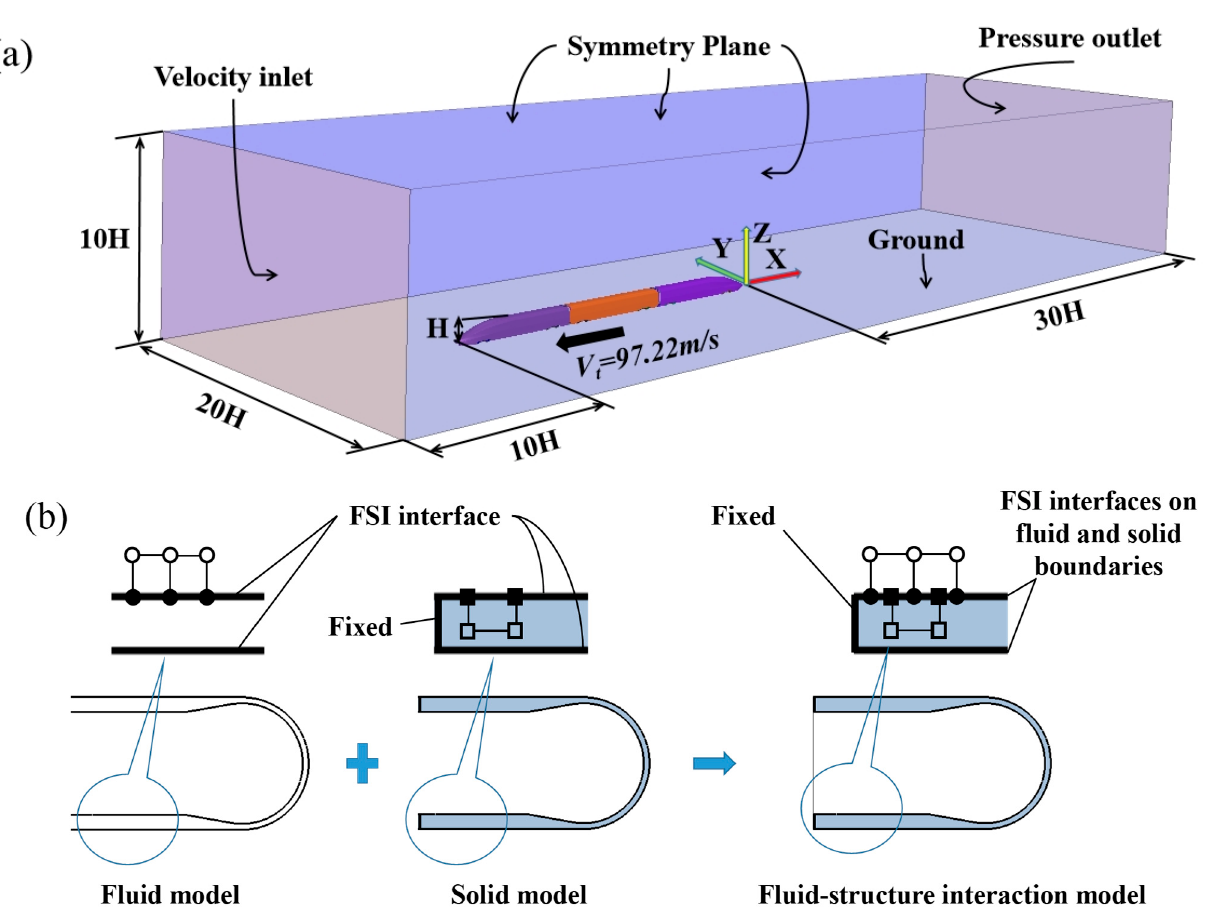
Figure 3. Boundary conditions and computational domain: ( a ) fluid model, ( b ) boundary conditions of FSI.